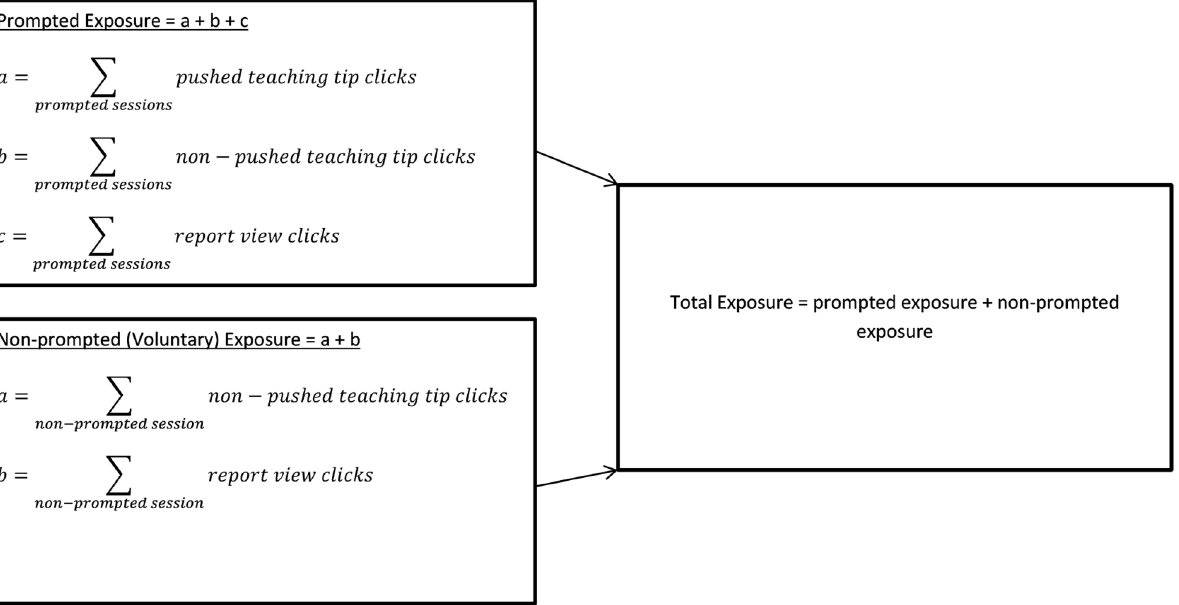
Figure 3. Components of the ESRA-C intervention with calculation of total